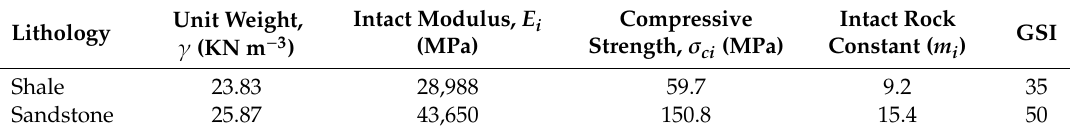
Table 1. Properties of intact rocks.